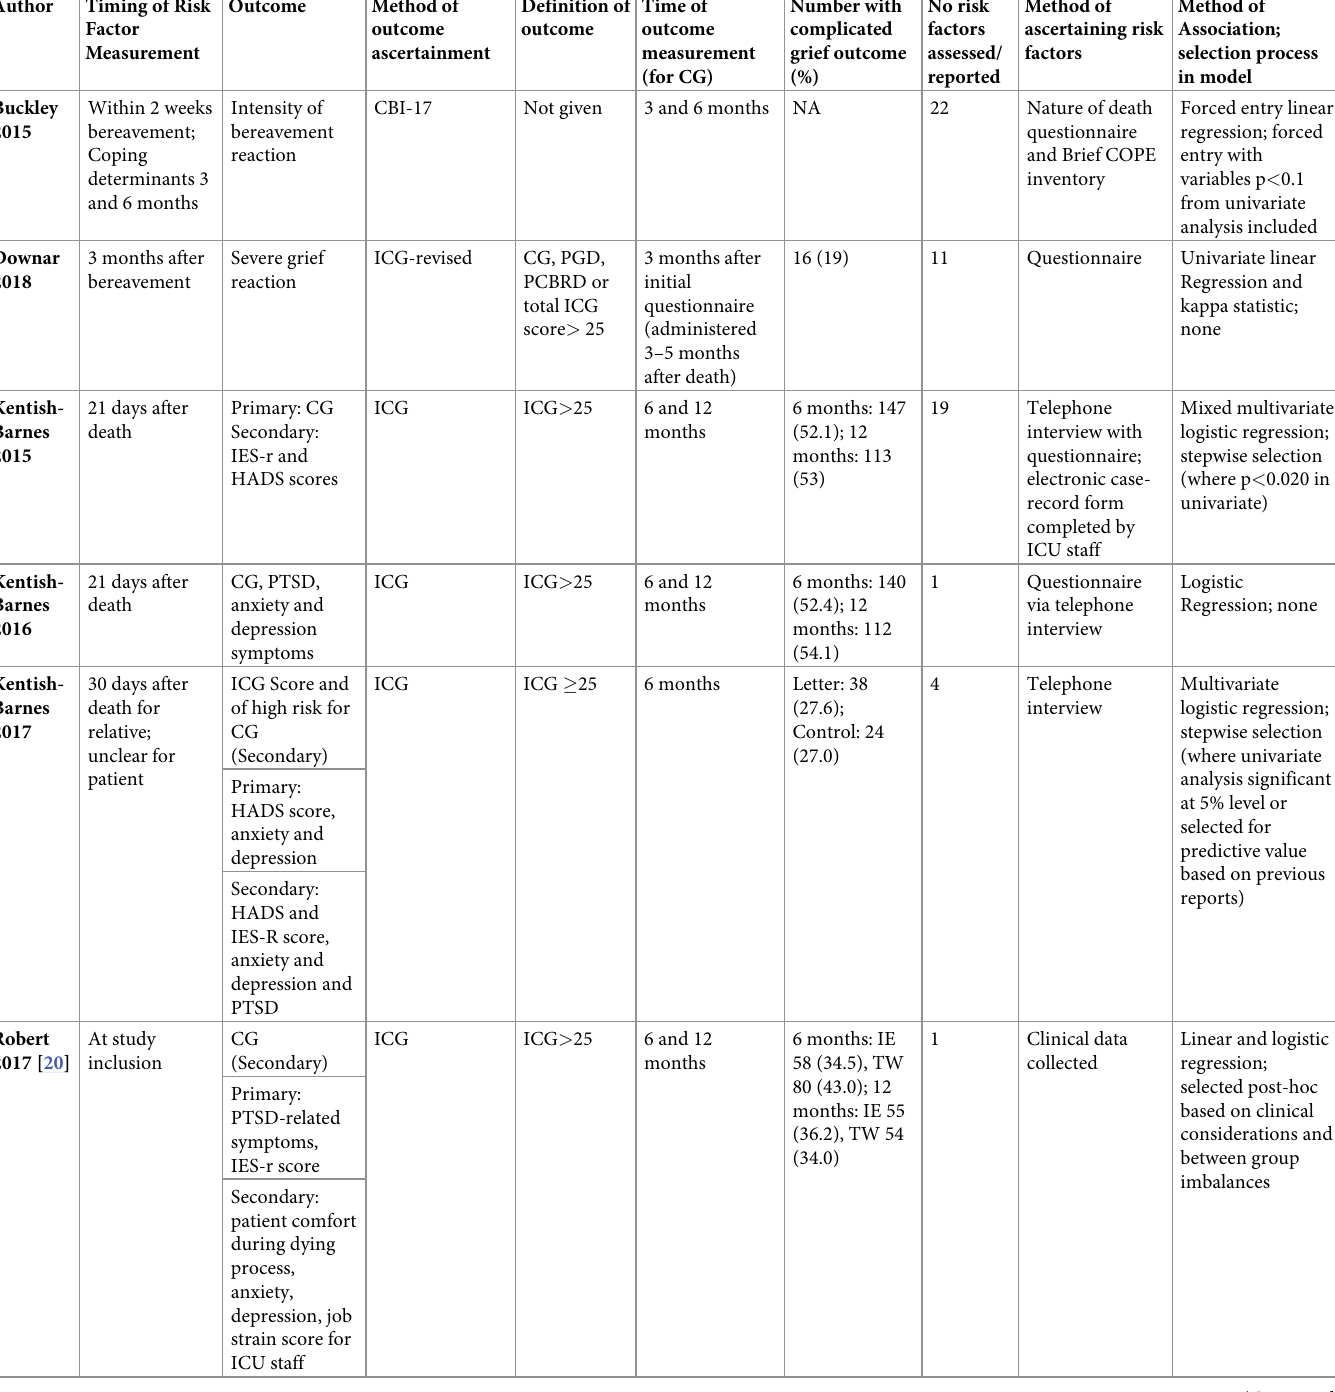
Table 2. Details concerning outcome measurement, risk factor measurement and method of association between the two for the articles investigating potential risk factors for complicated